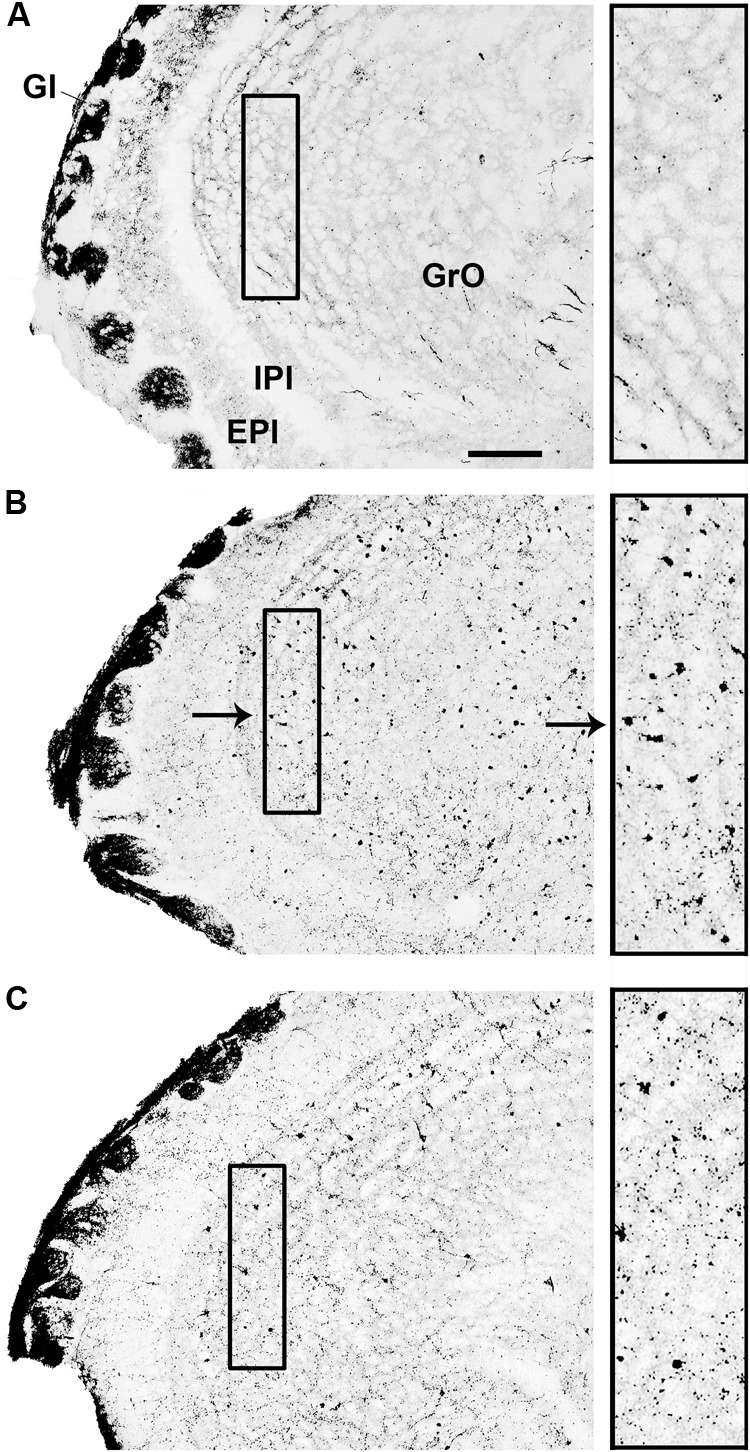
Infection with SLEV CbaAr-4005 induced numerous apoptotic-like A-Cu-Ag staining of cell bodies in the granule cell layer of the olfactory bulb (GrO). Compared to control mice (A), mice sacrificed at day 8 PI showed a clear increase in apoptotic-like cells in GrO (B). The increase in the number of apoptotic-like cells was less striking in mice sacrificed at day 11 PI than in those sacrificed at day 8 PI (C). Insets show augmented details of the areas where SLEV induced apoptotic-like degeneration in GrO. Sagittal sections, lat.1.13; the black arrow in (B) indicates an apoptotic-like A-Cu-Ag stained cell. Bar = 100 μm. This figure is representative of three independent experiments. GI, glomerular layer of the olfactory bulb. IPI, internal plexiform layer of the olfactory bulb. EPI, external plexiform layer of the olfactory bulb.